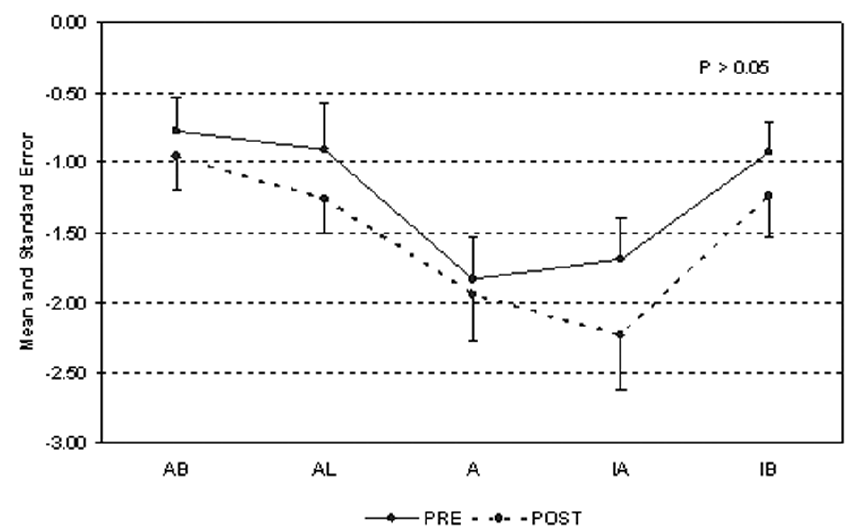
Figure 2 - Quantitatively, LV wall motion in the five regions did not differ pre- and postoperatively in EMF patients; AB – anterobasal; AL - anterolateral; A - apical; IA - inferoapical; IB –